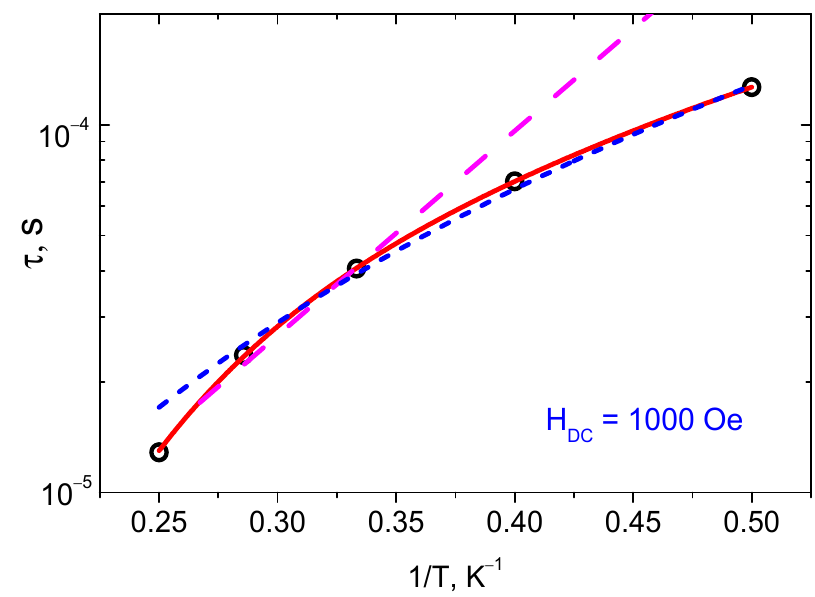
Figure 10. The dependence of the relaxation time τ on the reciprocal temperature 1/T for 7 . The points are obtained by approximating the frequency dependence of χ″ by the generalized Debye model. The magenta dashed line represents the result of the fit by the Arrhenius equation, the red line corresponds to the sum of Raman, direct, and Orbach relaxation processes, blue dashed line corresponds to the sum of the direct and Raman relaxation processes.